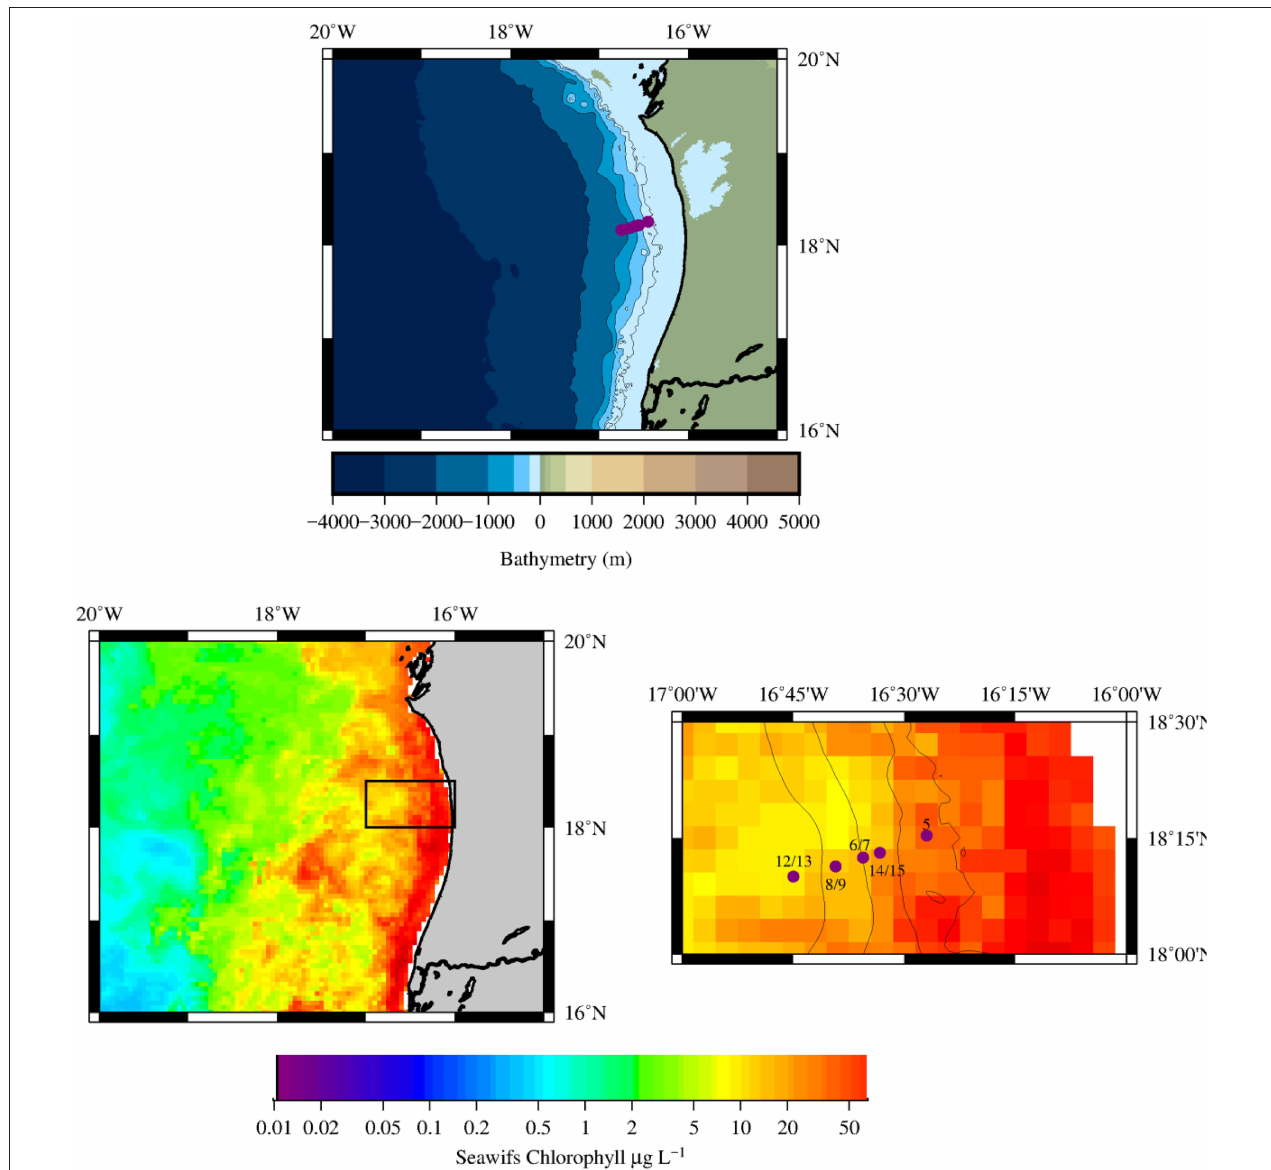
FIGURE 2 | (Top) Bathymetry of the Mauritanian upwelling region, the 5 stations occupied are shown as purple circles, note the presence of the Banc d’Arguin along the Mauritanian coast (bottom left) Chlorophyll composite map derived from MODIS-AQUA images for March 2011. The black box indicates the location of the main study region (bottom right) Composite image (bathymetry and satellite chlorophyll) of the study region with the location of the 5 main stations sampled in this work (purple circles).